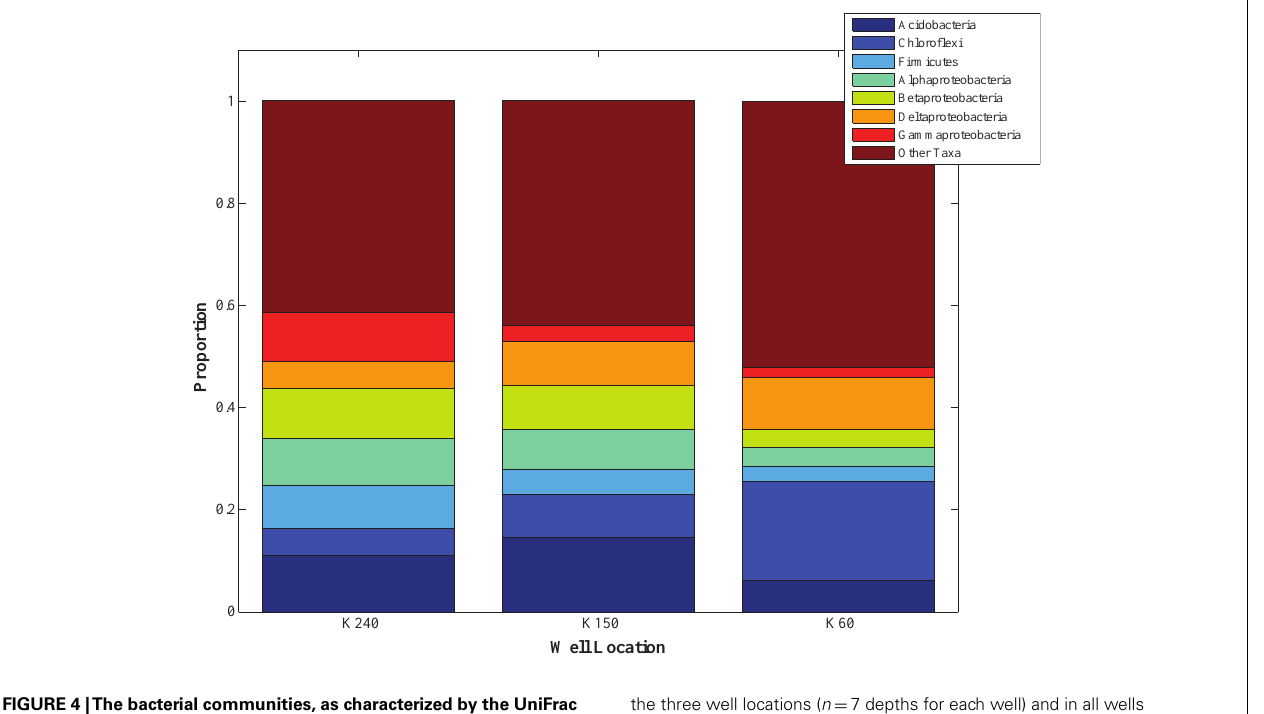
the three well locations ( n = 7 depths for each well) and in all wells combined. Although there are gradients in sediment texture and chemistry within the aquifer, only Mn was significantly different between wells (ANOVA, p <